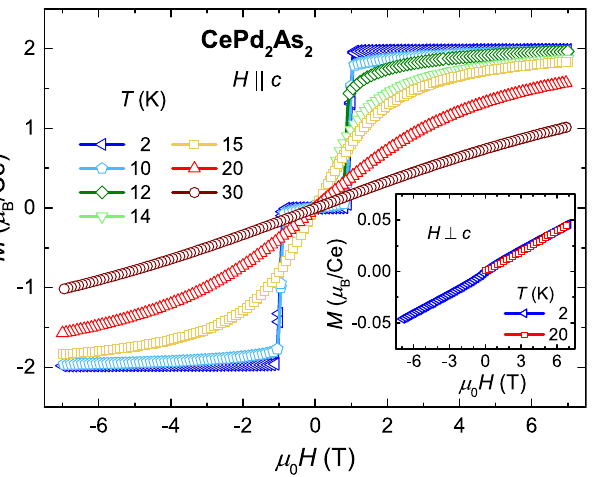
Figure 4. Isothermal magnetisation M ( H ) measured at different temperatures for magnetic fields applied along the c -axis and perpendicular to the c -axis